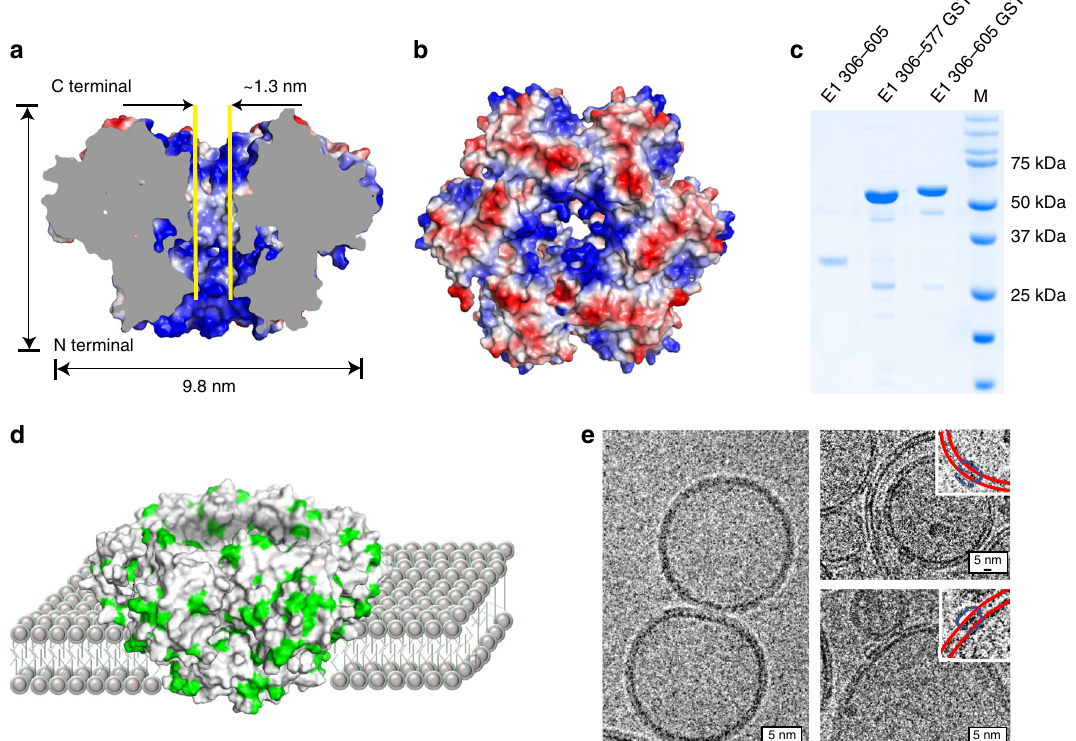
Fig. 1 The structure of BPV E1 helicase nanopore and its incorporation into liposomes. a , b Top and side view of the helicase nanopore showing a central lumen with diameter of c.a. 1.3 nm 28 (PDB ID: 5a9k). Coloring scheme of red for negative, white for neutral, and blue for positive electrostatic potential was used. c Coomassie-blue stained SDS-gel showing different constructs of helicase nanopore from truncated BPV E1. d A schematic drawing illustrating the insertion of a helicase nanopore into a lipid bilayer, with protein hydrophobic residues colored in green. According to the analysis of membrane insertion results, the helicase nanopore can be inserted into lipid bilayer membrane in either orientation. N-terminal insertion case was shown in the illustration. e Cryo-EM image of DPhPC liposome vesicles containing helicase nanopores. Left: Control sample of liposome vesicle only; Right: C-terminal (top right) and N-terminal (down right) insertion into the lipid bilayer of the liposome vesicle ( n = 67 from 46 trials). Insets highlighting bilayer membrane (red solid lines) and helicase nanopore (blue dashed lines) were provided in a magni fi ed view. Source data used to generate panels c and e in this fi gure can be